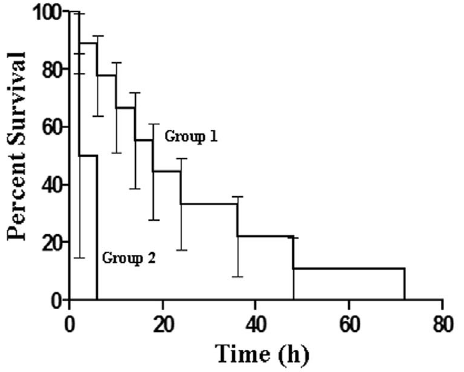
Figure 4. Kaplan-Meier model of the survival rate of the animals with ADP induced coronary thrombosis in the presence and absence of the application of dermal SNP ‘‘pad’’. To determine the survival rate in the animals from coronary thrombosis by the dermal application of SNP ‘‘pad’’ induced by ADP, Kaplan-Meier survival curve was plotted. Group 1 represents the animals that received the dermal application of SNP ‘‘pad’’. The curve indicates the survival period which shows survival of the animals up to 72 hours after the repeated injection of ADP. Group 2 represents the control group without SNP ‘‘pad’’ treatment. The survival time of the animals was less than an hour as shown by the curve.